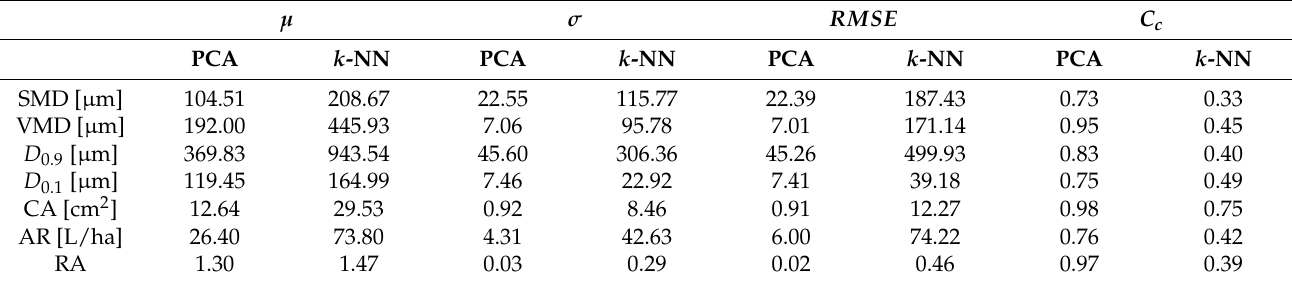
Table 9. Statistics of the PPQD soft-sensor predictor with PC regression compared to the k -NN regression.